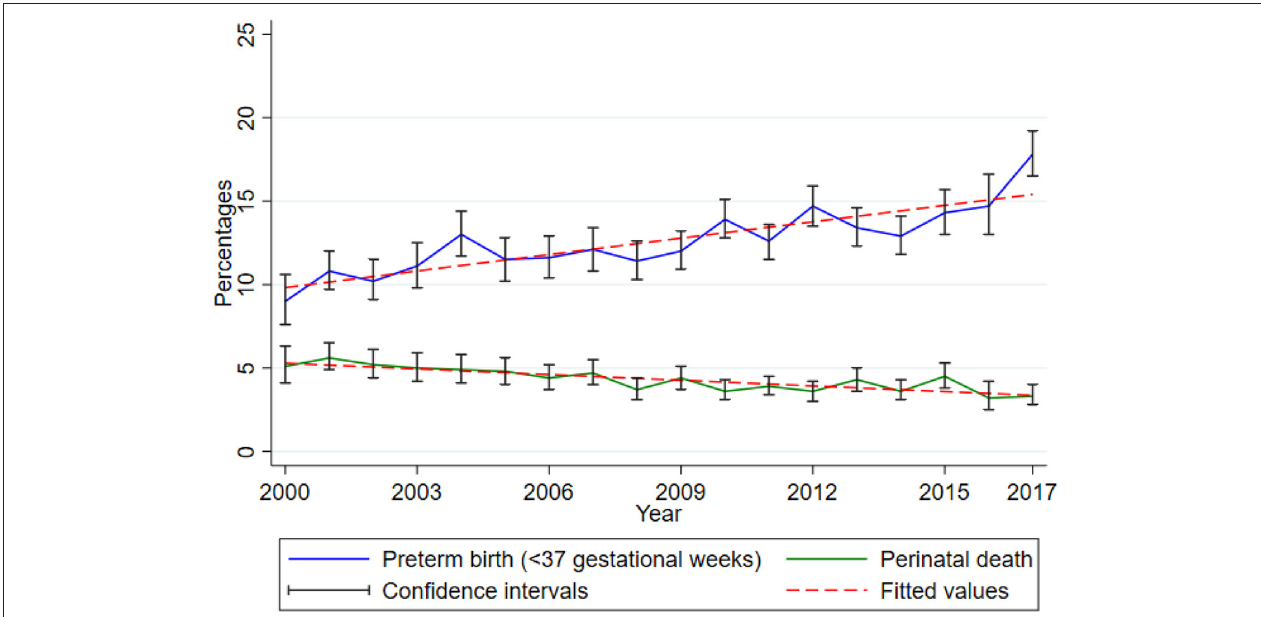
FIGURE 2 | Trends of preterm birth and perinatal death. Data from the Kilimanjaro Christian Medical Center (KCMC) Medical Birth Registry, 2000–2017.